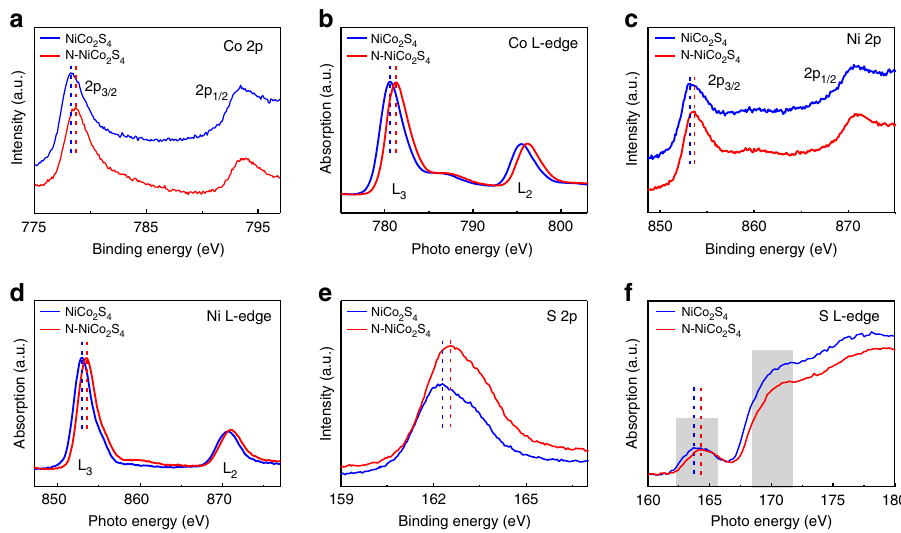
Fig. 3 XPS and XANES characterization of NiCo 2 S 4 and N-NiCo 2 S 4 . XPS core-level spectra of a Co 2p, c Ni 2p, and e S 2p for NiCo 2 S 4 (blue) and N – NiCo 2 S 4 (red). XANES spectra of b Co L-edge, d Ni L-edge, and f S L-edge for NiCo 2 S 4 (blue) and N – NiCo 2 S 4